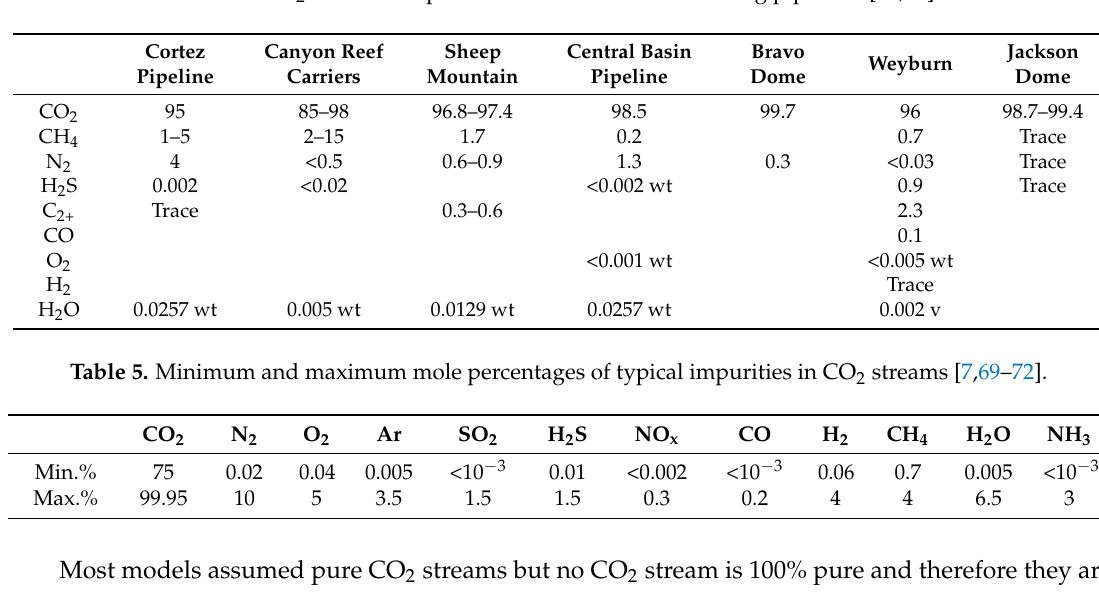
Table 4. CO 2 stream composition in mol % of some existing pipelines [35,59].